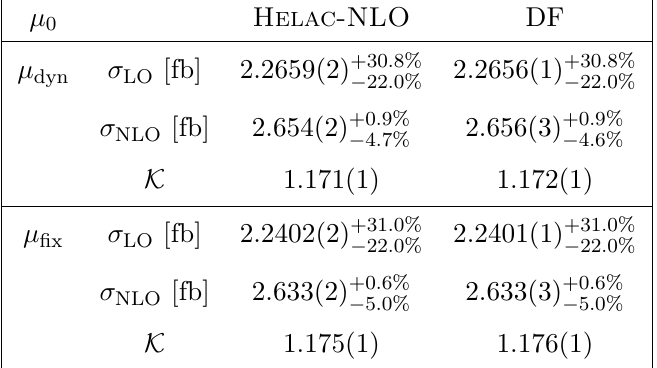
Table 1 . Integrated cross section at LO and NLO QCD for the pp → e + ν e µ − ¯ ν µ b ¯ b H process at the √ LHC with s = 13 TeV. Results are evaluated using µ 0 = µ dyn and µ 0 = µ fix for the CT10NLO PDF set. Also given is a comparison between Helac-Nlo and the results from ref. [33] (indicated by